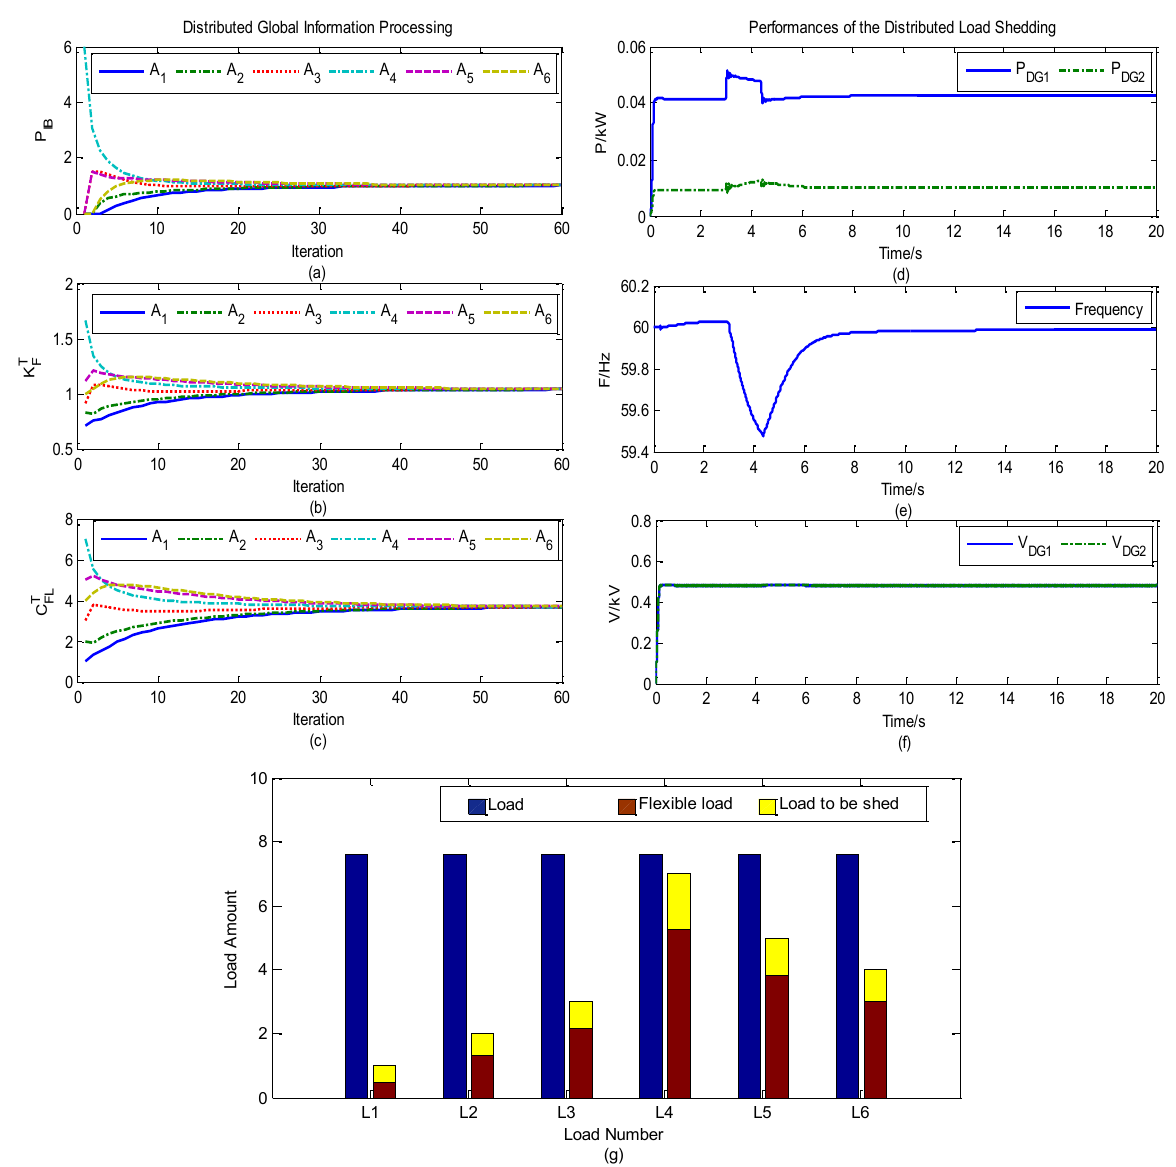
Figure 5. The distributed global information processing and the performance of the distributed load shedding of Case B. ( a ) The information processing of the active total power imbalance P ; ( b ) the information processing of the total cost coefficient K T IB ( c ) the information processing of the total amount of flexible loads C T outputs of DGs; ( e ) The frequency response of the islanded microgrid; ( f ) the voltage responses of DGs; ( g ) the amounts of the flexible loads and the amounts of loads to be